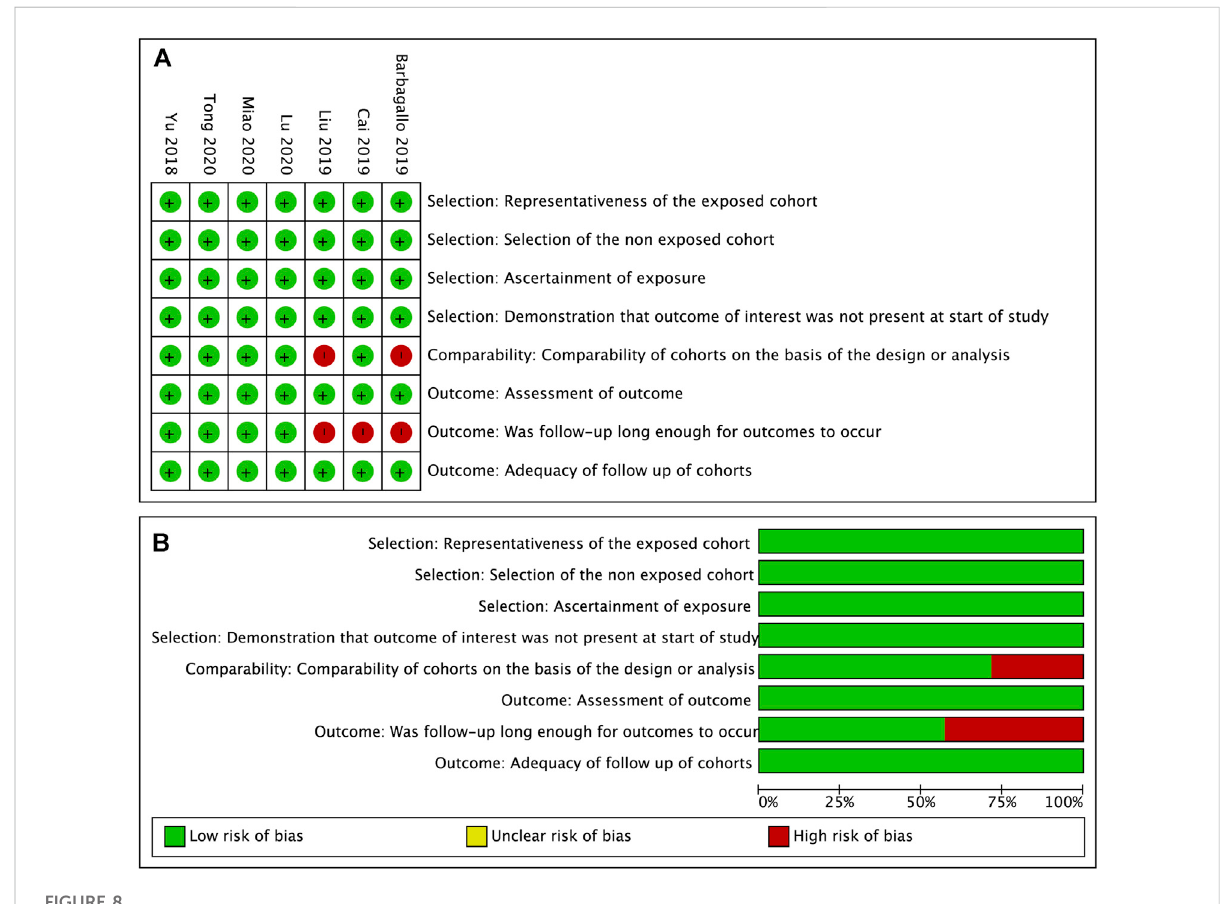
FIGURE 8 Quality assessment of the included studies. (A) . Each risk of bias item for each included study. (B) . Each risk of bias item presented as percentages across all included